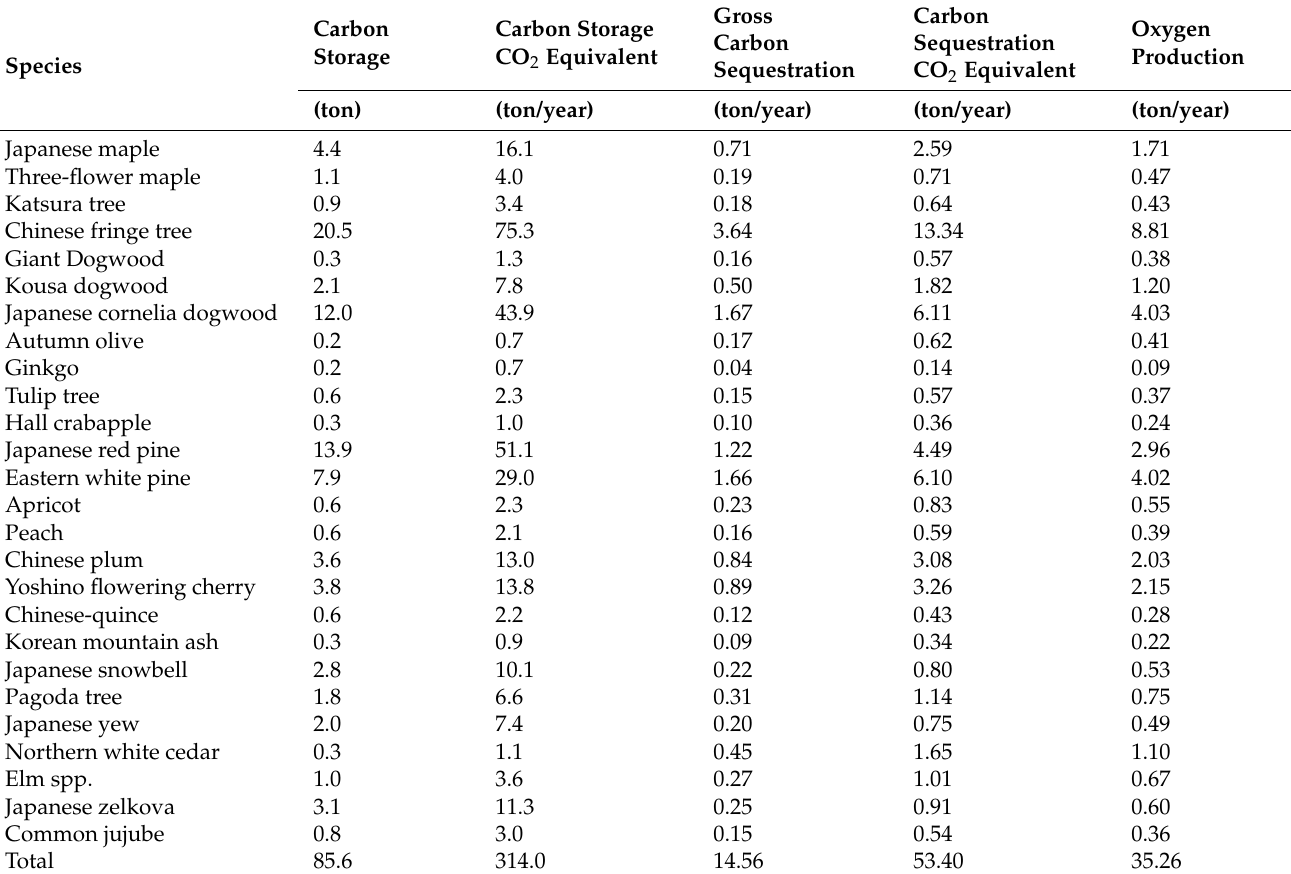
Table 4. Carbon storage and carbon sequestration of trees by